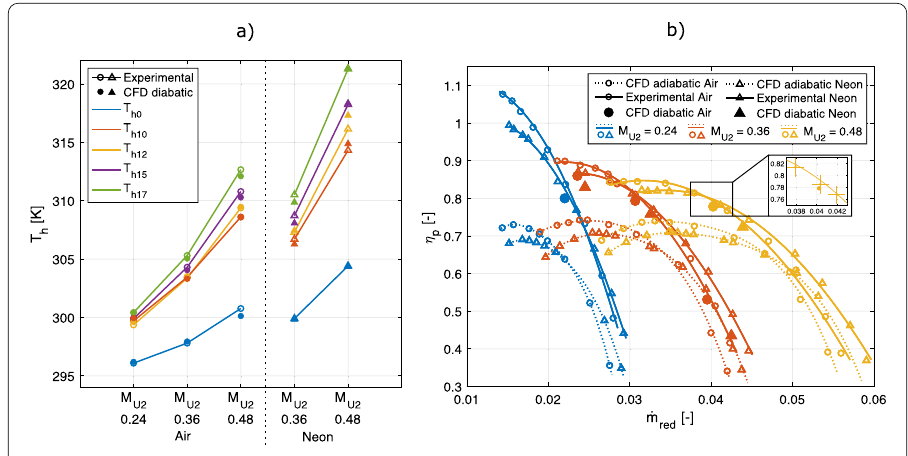
perature measured at five operating points to numerical predictions. Overall, the mea- sured temperature distribution on the housing outer wall is well captured by the numer- ical prediction. The first three operating points correspond to air operation at three tip Mach number and about the same inlet flow coefficient of 0.07. With increasing tip Mach number the impeller outlet temperature progressively increases together with the motor power. In turns, the thermal equilibrium leads to an increase of the housing outer wall temperature. The last two operating points correspond to neon operation. All tempera- tures at a same tip Mach number than for air operation are thus higher due to a higher specific heat ratio and a resulting higher impeller outlet temperature.